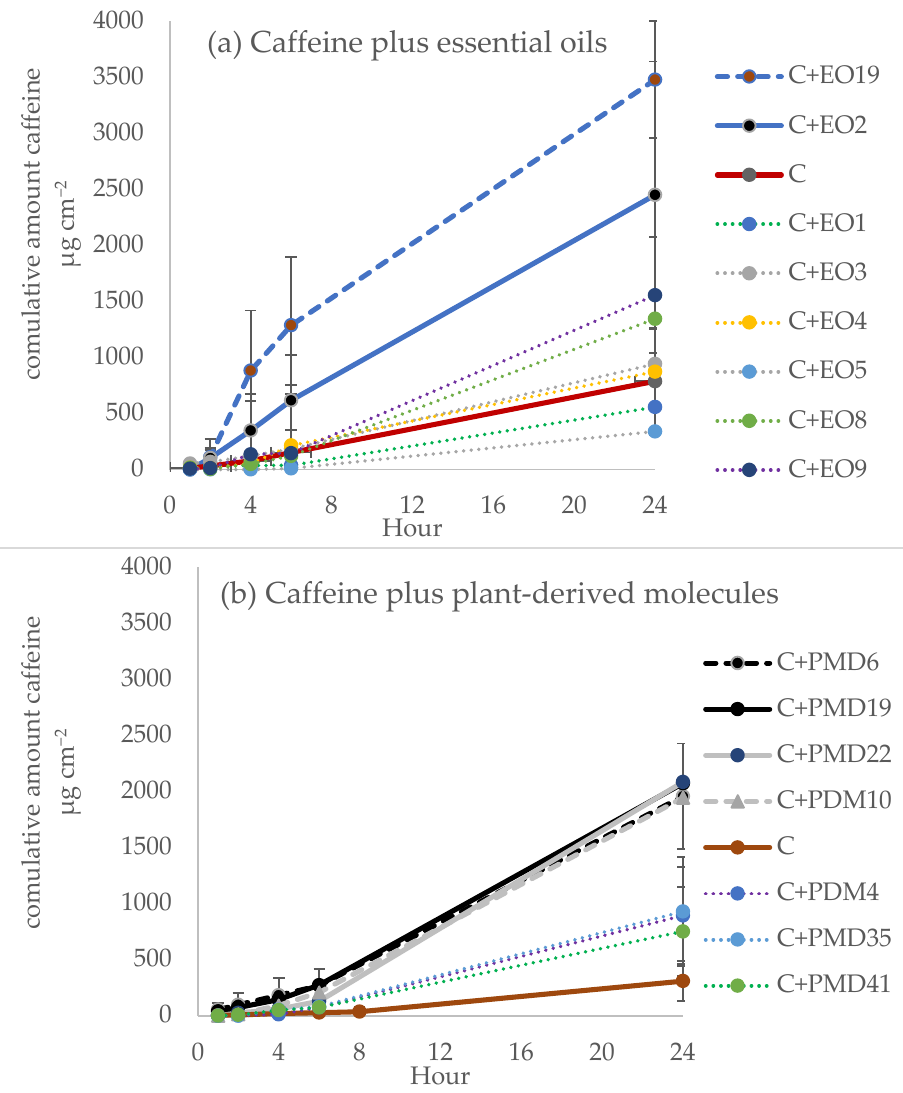
Figure 2. Skin permeation profiles of caffeine gel through full-thickness mouse skin at different times. Formulations of caffeine plus ( a ) essential oils (EOs) and ( b ) plant-derived metabolites (PDMs) Mean ± SD ( n = 6). The codes for each permeant are shown on the table.